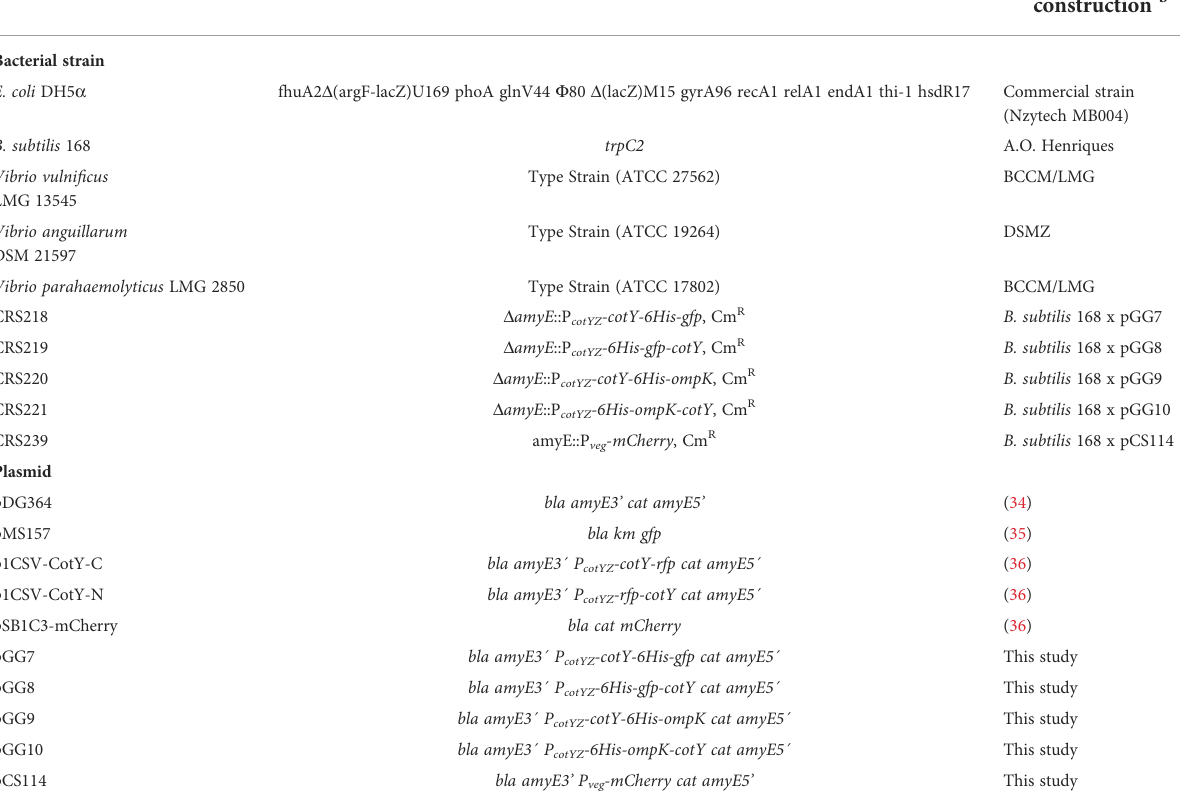
TABLE 1 Bacterial strains and plasmids used in this